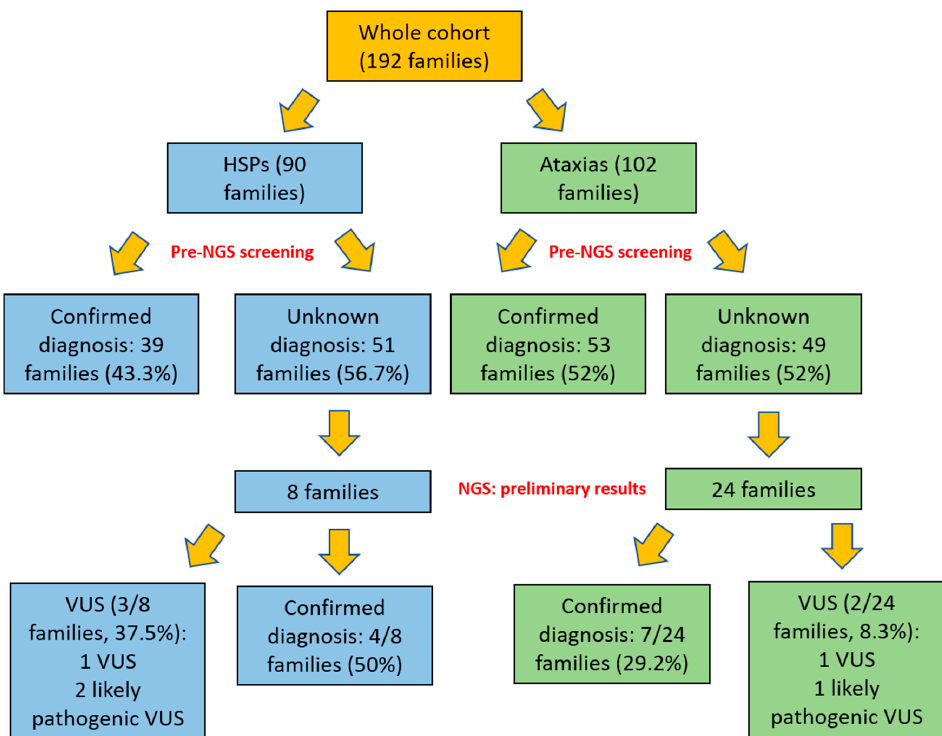
Figure 5. Schematic representation of the results of the diagnostic route in our cohort of SCA and HSP cases.